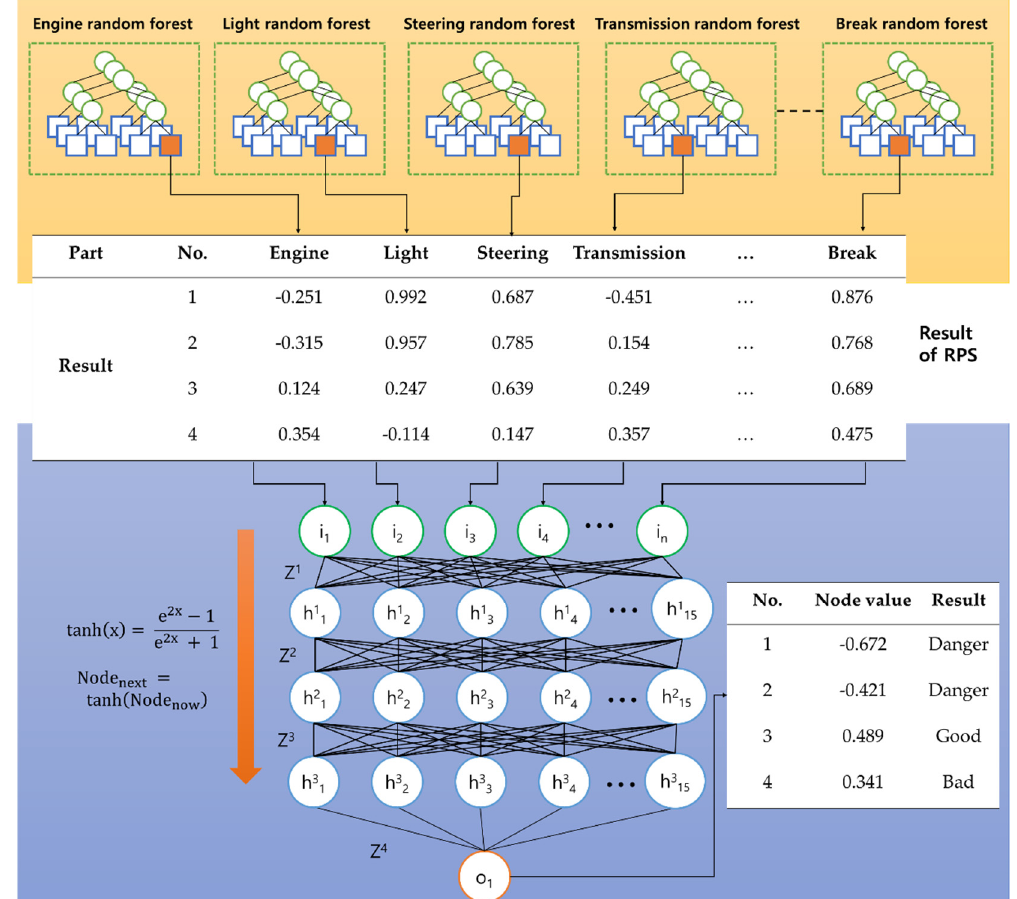
Figure 12. A process of the total diagnosis using the NNVS.